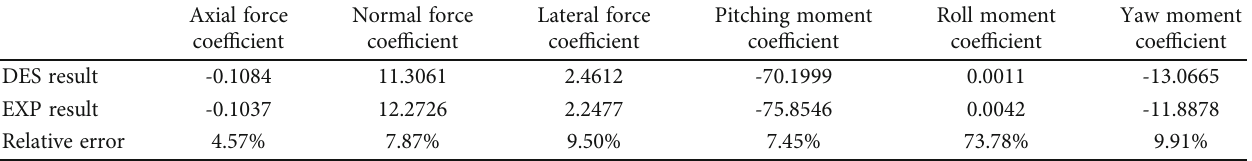
Table 6: The comparison between DES simulation results and experimental results after coordinate transformation.